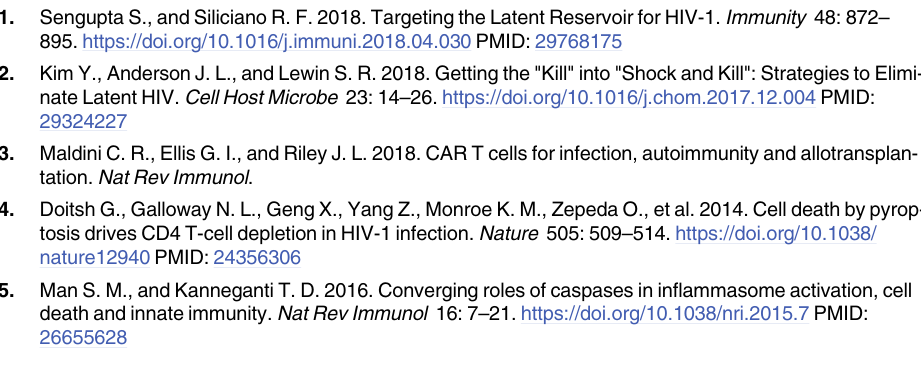
50 μ M QVD. (F) RNA-Seq-based differential gene expression analyses on primary CD4 T cells infected with Nef+ or Nef- HIV-1 from 2 donors for genes involved in TLR or IL-2 signal- NL4-3 ing pathways. ( G ) Protein-interaction network connecting various apoptotic pathways as depicted by Cytoscape (http://cytoscape.org) and String-Db (http://string-db.org). The shared components among the pathways are highlighted in red